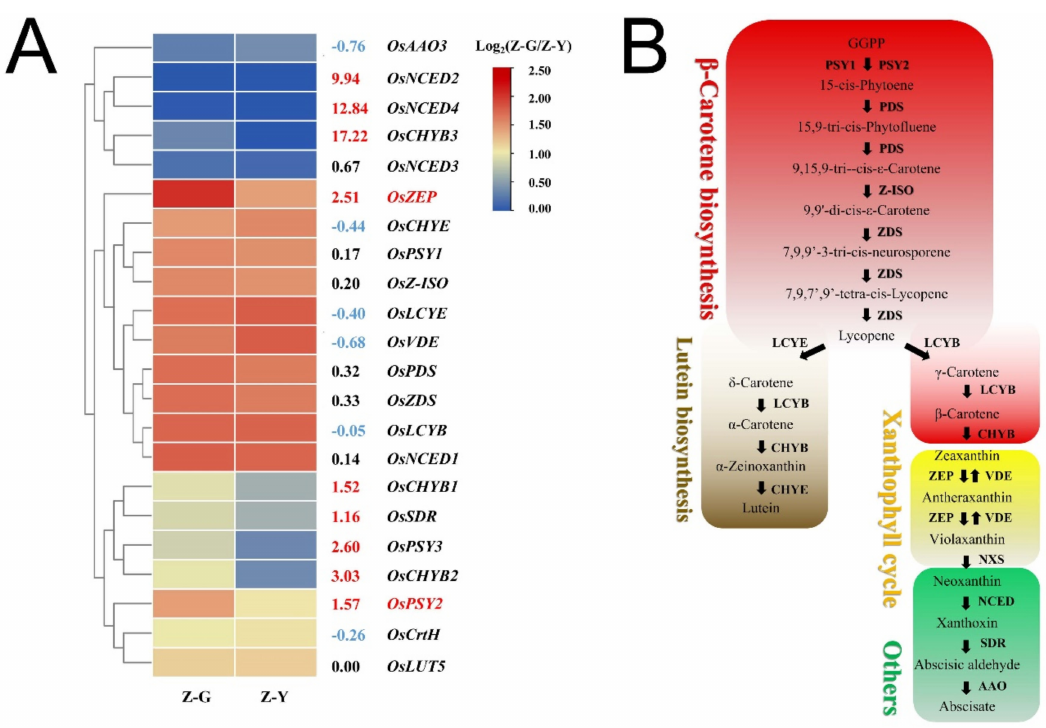
Figure 4. Transcriptome analysis of gene expressions involved in carotenoid biosynthesis-related pathways in the striped leaves of B03S. ( A ) Heatmap analysis of gene expressions in carotenoid pathways. ( B ) Metabolite and enzyme in four processes of carotenoid metabolic pathway. Data are normalized and transformed by log 2 FC of gene expression in zebra-green striped leaves com- pared to those in zebra-yellow striped leaves ( n = 3). FC, fold change; Z-G, zebra-green striped in leaves/alternate green leaves; Z-Y, zebra-yellow striped in leaves/alternate yellow